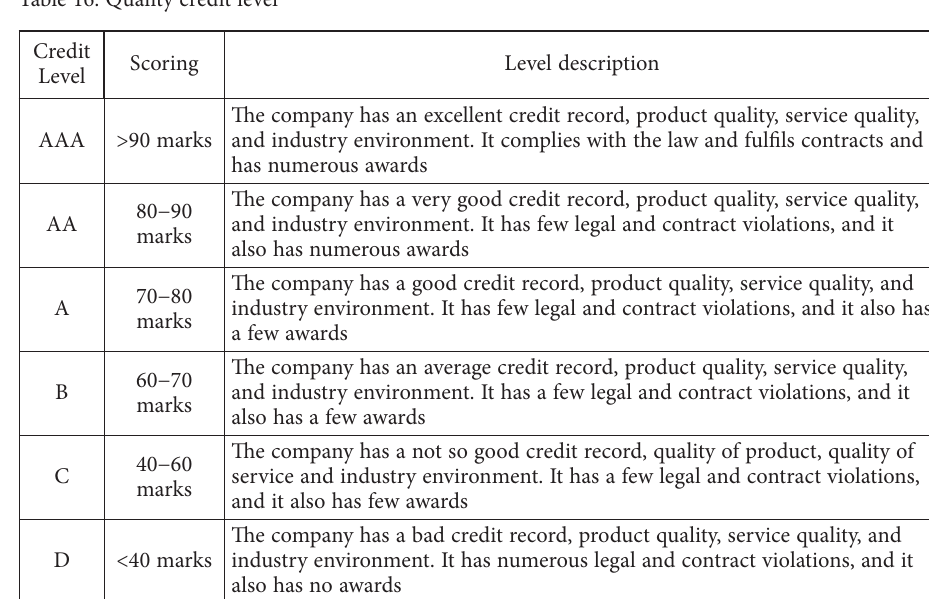
Table 16. Quality credit